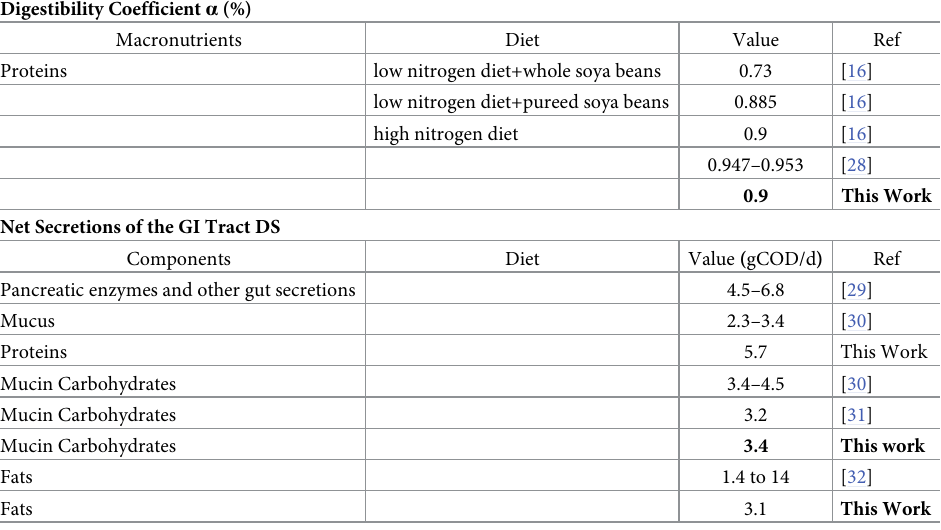
Table 2. Survey of ileal digestibility coefficients from the literature and our estimates (this